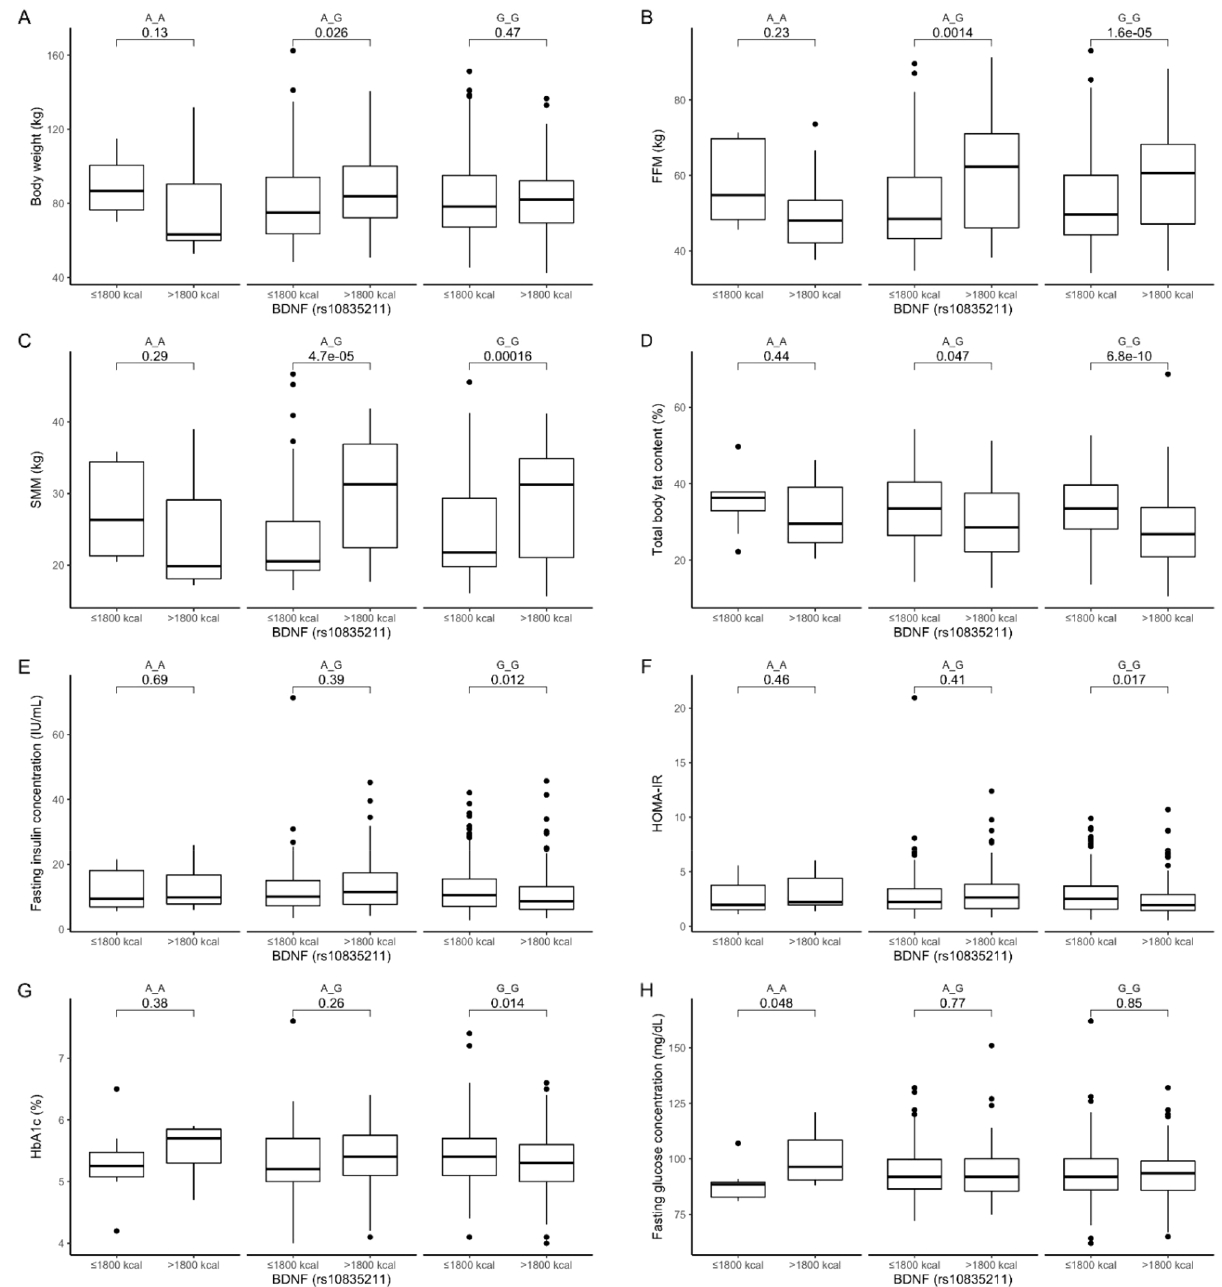
Figure 1. The ( A ) body weight (kg); ( B ) FFM (kg); ( C ) SMM (kg); ( D ) total body fat content (%); ( E ) fasting insulin concentrations (IU/mL); ( F ) HOMA-IR; ( G ) HbA1c; and ( H ) fasting glucose concentration (mg/dL) in BDNF rs10835211 genotype carriers, stratified by daily energy intake (≤ 1800 kcal and > 1800